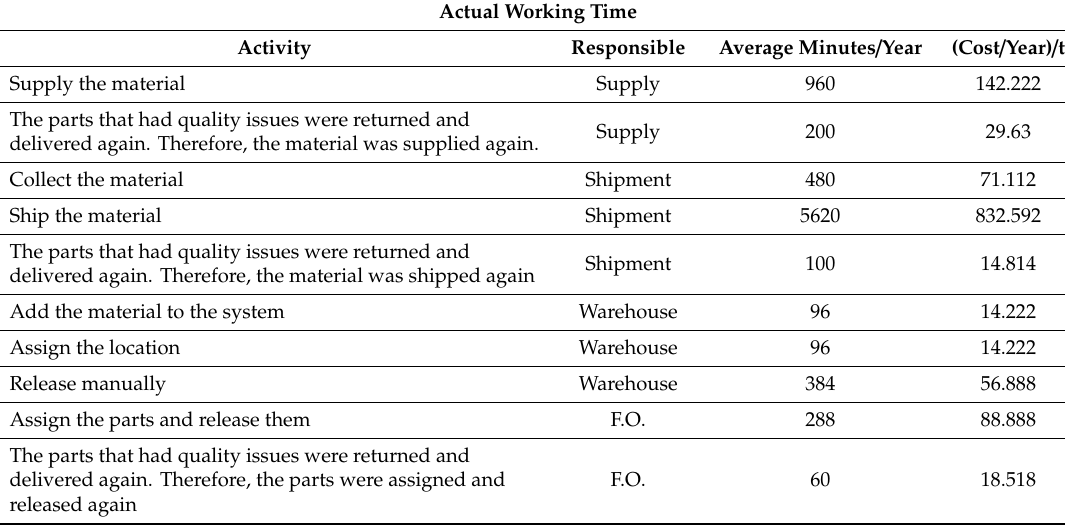
Figure 4. The second part of seven of the Current VSM is displayed. Figure 5. The third part of seven of the Current VSM is displayed.